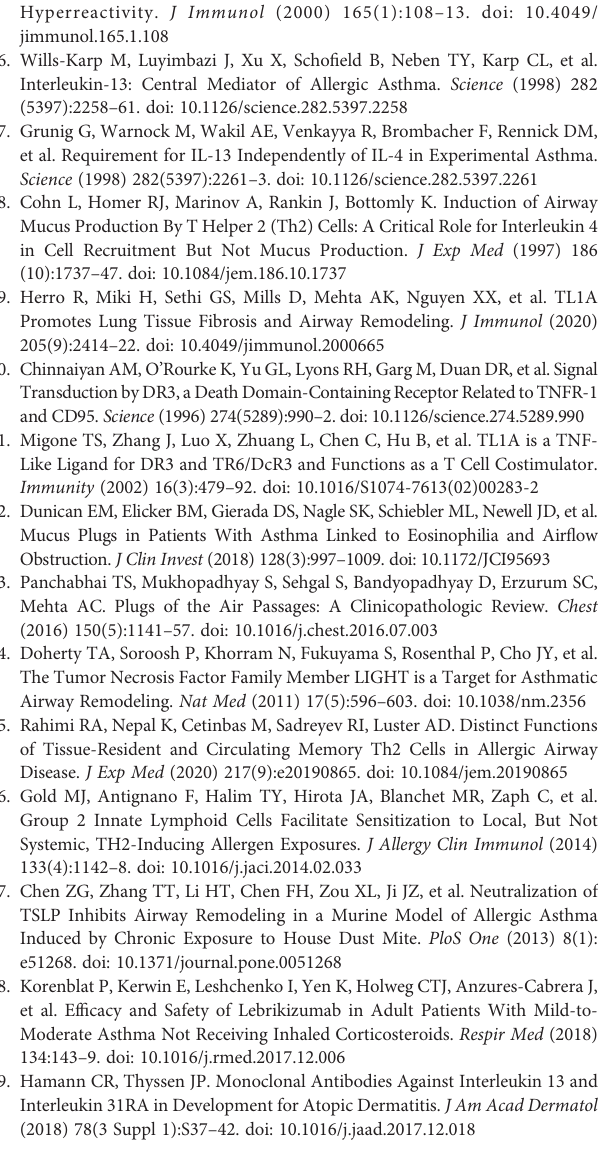
Supplementary Figure 2 | TL1A inhibition decreases the in fi ltration of ILC2 in the lungs and airway fi brosis. (A) Quanti fi cation of Masson Trichrome and H&E scores in the lungsofHDM-induced miceare shown. (B) Flowcytometry analysis ofcellular in fi ltration in the bronchial lavage of mice induced with HDM as previously described. The grey dotted line indicates baseline in fi ltration. (C) Numbers of ILC2 in the left lobe of the lungs of mice induced with HDM. The grey dotted line indicates baseline in fi ltration. (D) Gating strategy of ILC2 cells used during the sorting. All results are representative of 10 mice per group. One-way Anova using a multi-comparison to WT HDM is used to calculate the p values. *p < 0.05, ***p < 0.0005. Supplementary Figure 3 | IL13 and IL4 expression in the lungs of TL1A -induced mice. (A) Relative expression of IL4 and IL13 in the lungs of RAG and RAG g c- de fi cient mice induced with TL1A as previously described. (B) Relative expression of IL4 and IL13 in the lungs of WT (BALBc) and IL4R a - de fi cient mice induced with TL1A as previously described. All results are representative of 4 mice per group. *p <